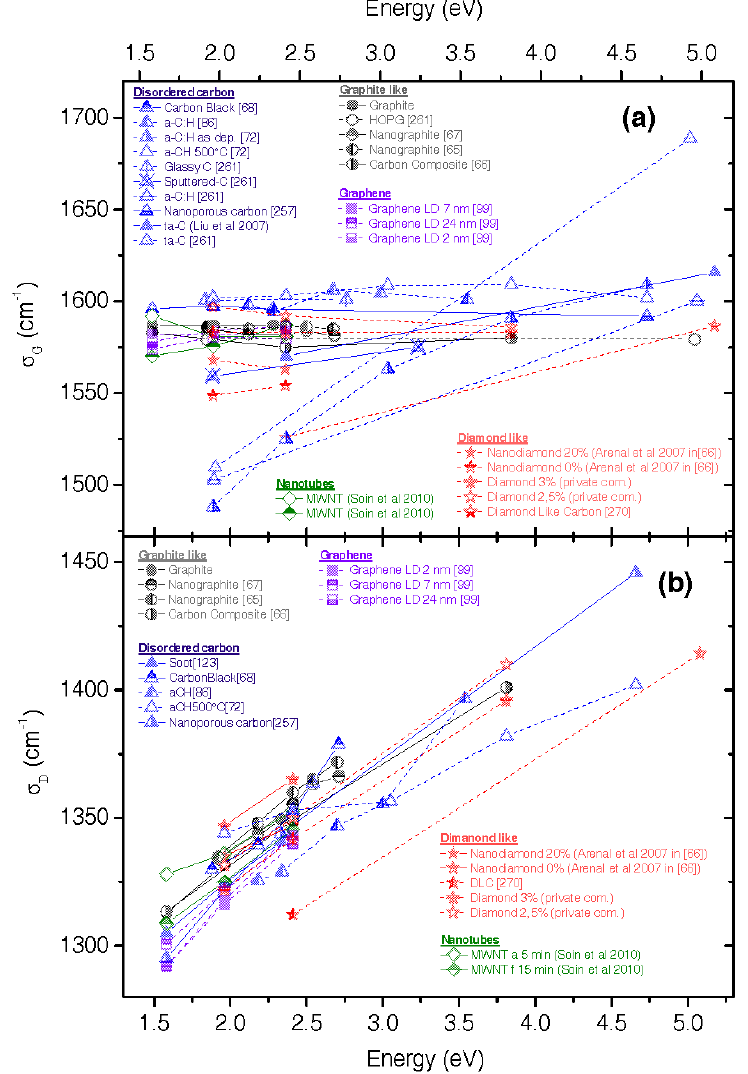
Figure 7. Dispersion relations of the ( a ) G band and ( b ) D band for many disordered samples (data derived from literature as indicated).